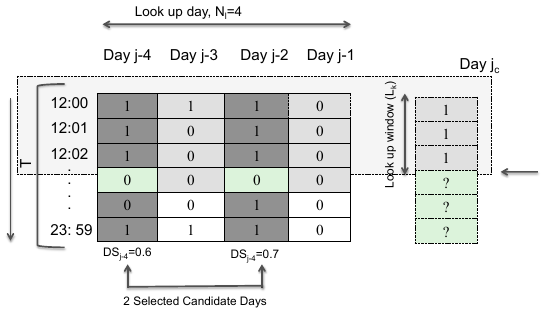
Figure 3: Example of the Network Activity Prediction and TTL Estimation